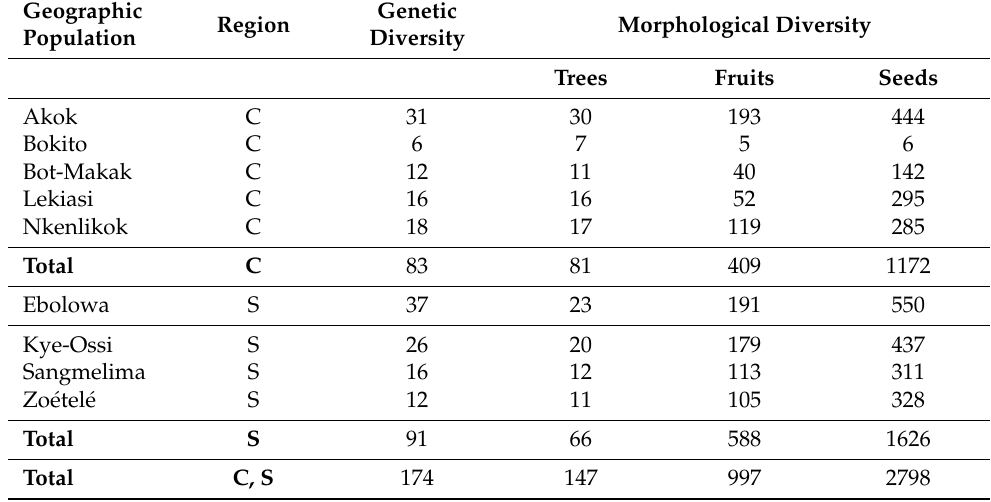
C = Central region, S = South region. Table 10. Tree growing sites across